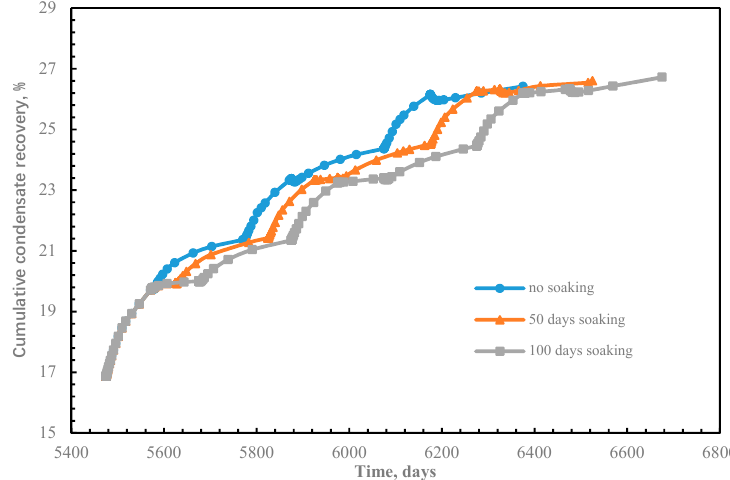
Figure 18. Cumulative condensate recovery for different soaking at 5000 injection pressure.